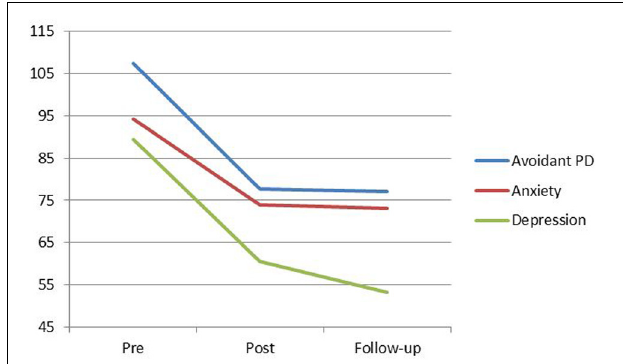
FIGURE 4 | Total YSQ-S2 and GSI group means from pre-treatment through mid-, post-, and follow-up.